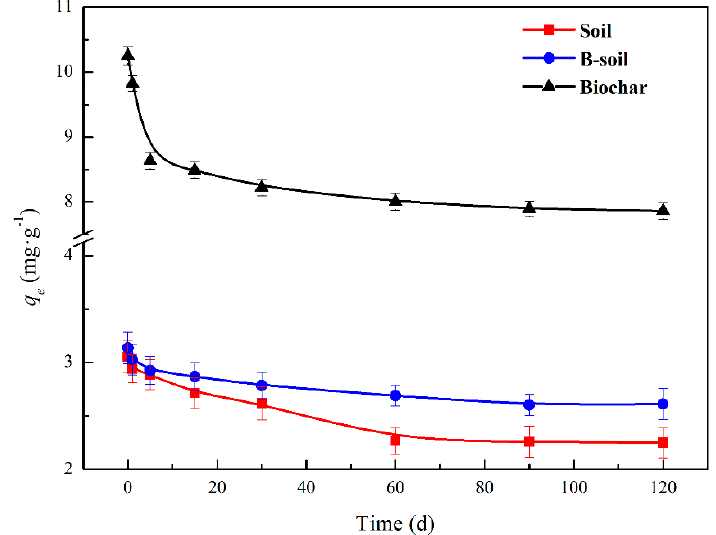
Figure 4. Effect of DOM with different degrees of decomposition on BPs adsorption on the samples.